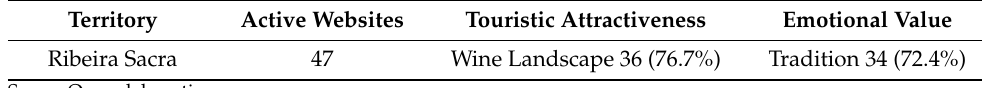
Table 6. Touristic attractiveness and emotional value in the websites of the Ribeira Sacra AO. Territory Active Websites